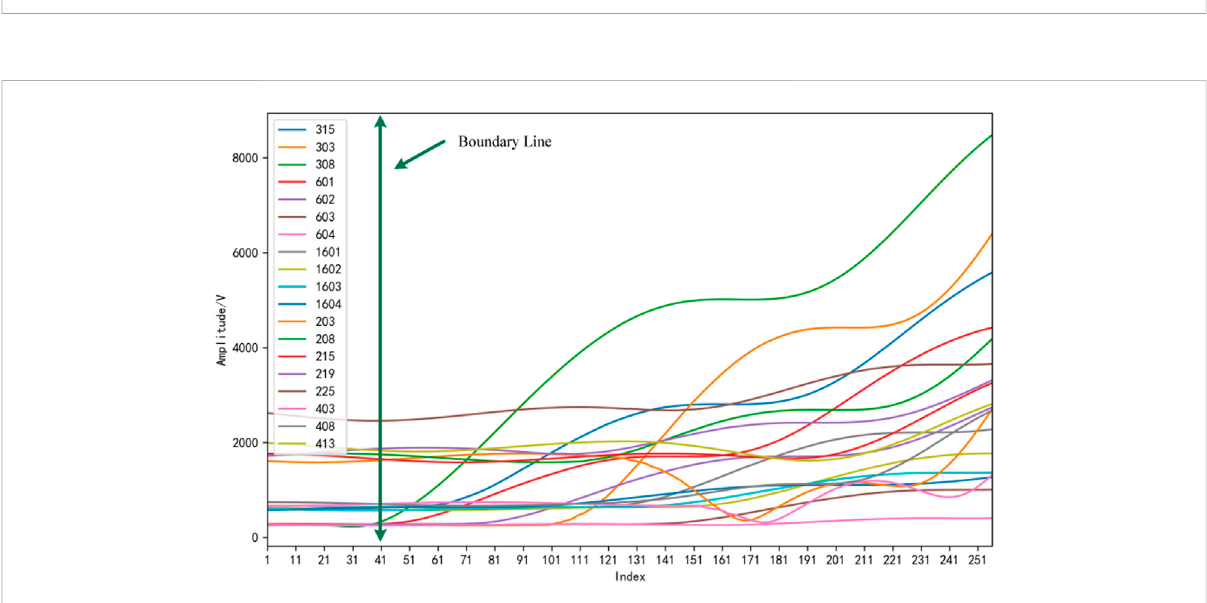
FIGURE 5 3U 0 amplitude change curve when a single-phase grounding fault occurs in arc suppression coil grounded and ungrounded